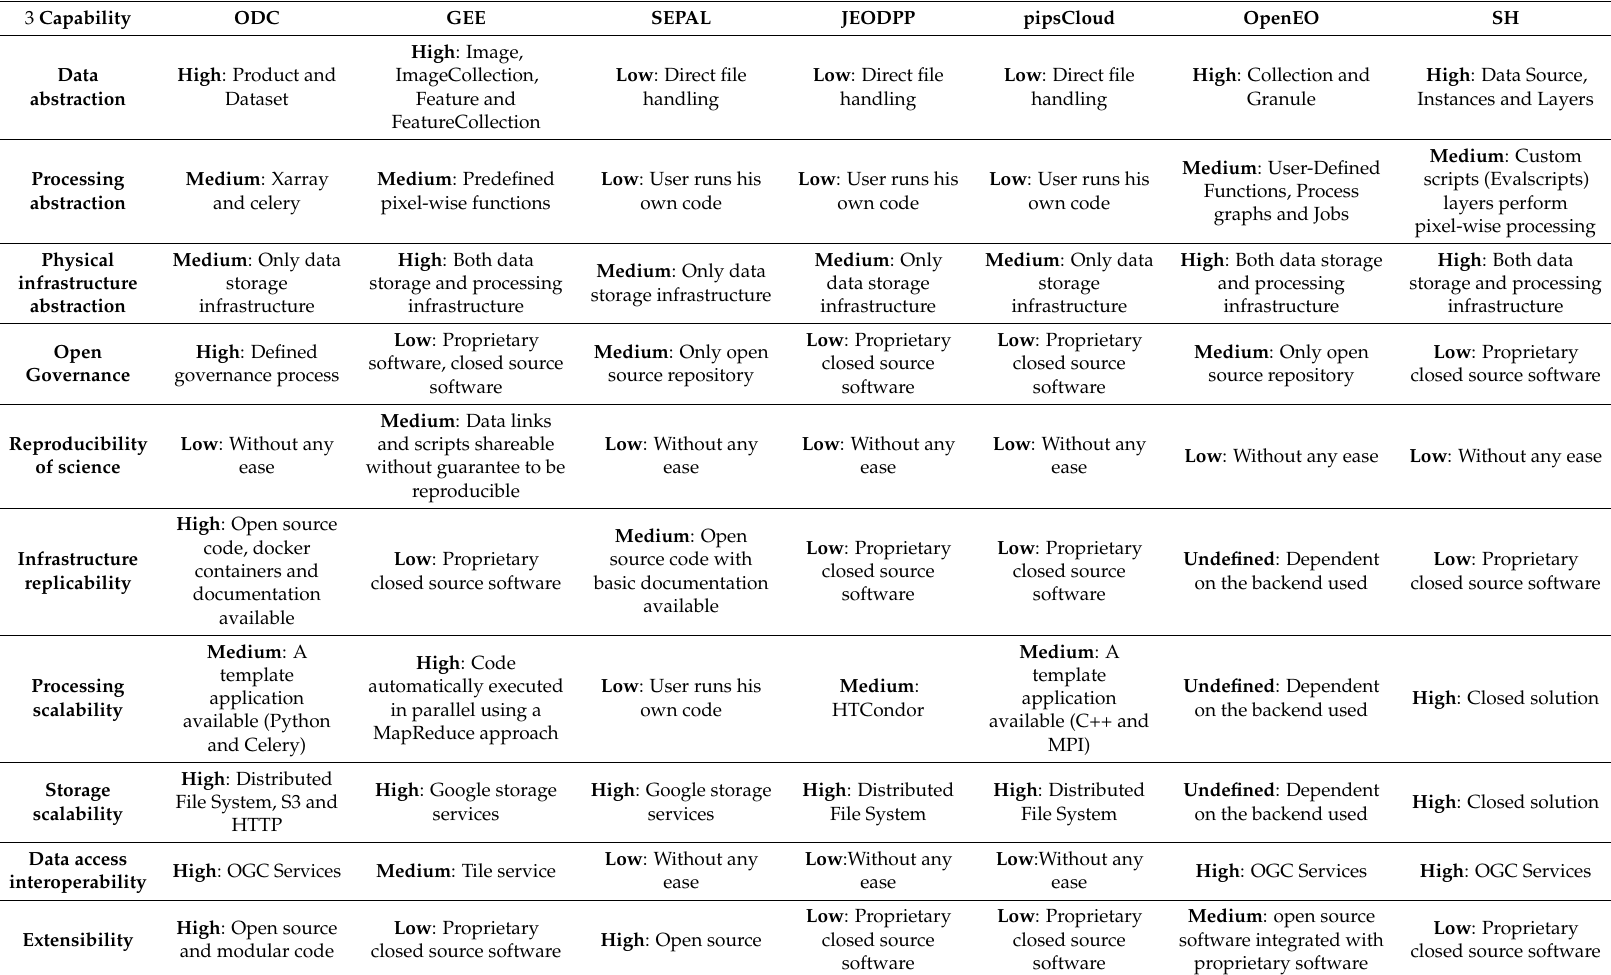
Table 1. Capacities of the platforms for big EO data management and